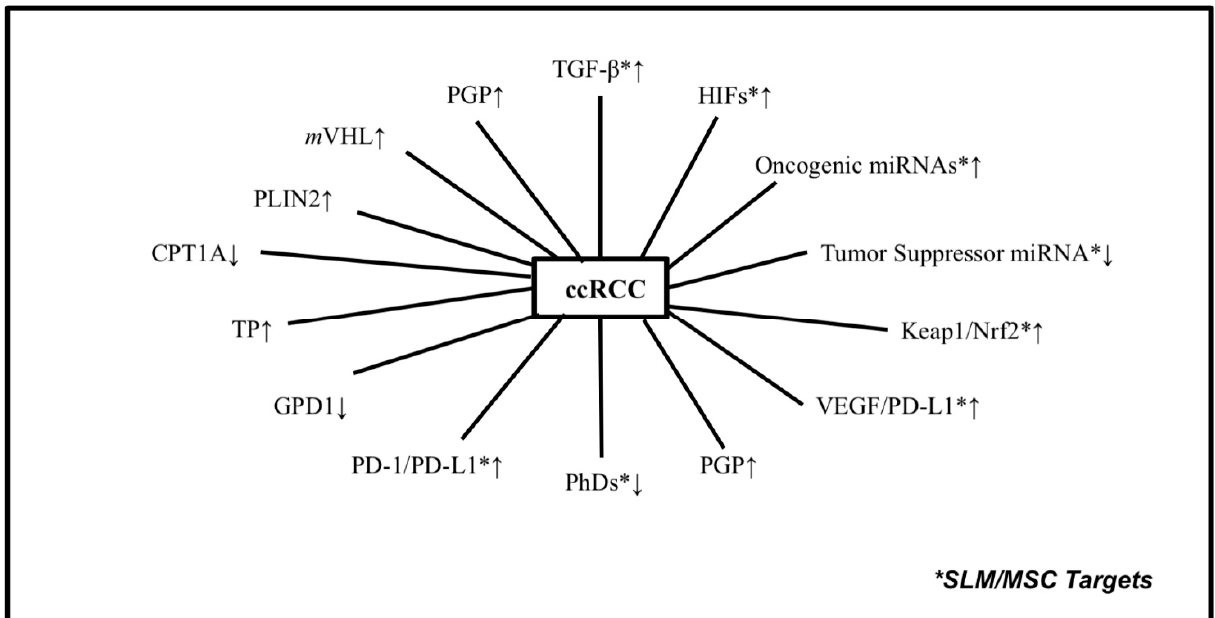
Figure 1. Molecular and immunologic targets expressed in ccRCC tumors and associated microenvironment implicated in tumor angiogenesis, unstable microenvironment, drug resistance, and immune evasion. TGF-ß, transforming growth factor-ß; HIFs, hypoxia-inducible factor1 α /2 α ; onco-miRs, oncogenic microRNAs; TSmiR S , tumor-suppressor microRNA S ; P-gp, p-glycoprotein; PHD, prolyl hydroxylase; PD-1/PD-L1, programmed death-1 and its ligand; GPDL1, glycerol-3-phosphate dehydrogenase 1-like; TP, thymidine phosphorylase; CPT1A, carnitine palmitoyl transferase IA; PLIN2, Perilipin 2; mVHL, mutated Von Hippel-Lindau tumor-suppressor gene; ↑ upregulated; ↓ downregulated. *: SLM/MSC targets.